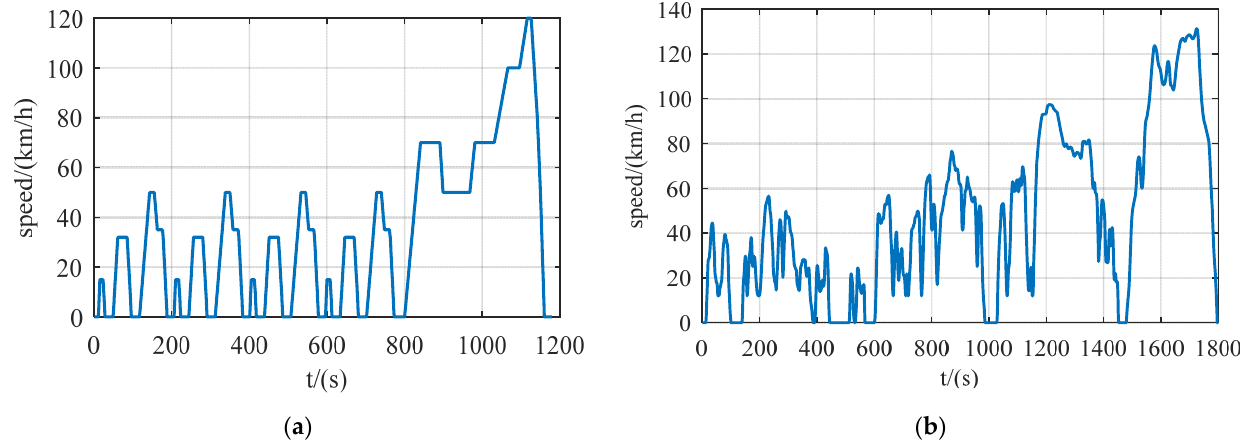
Figure 6. ( a ) The target speed curve for NEDC; ( b ) the target speed curve for WLTC.